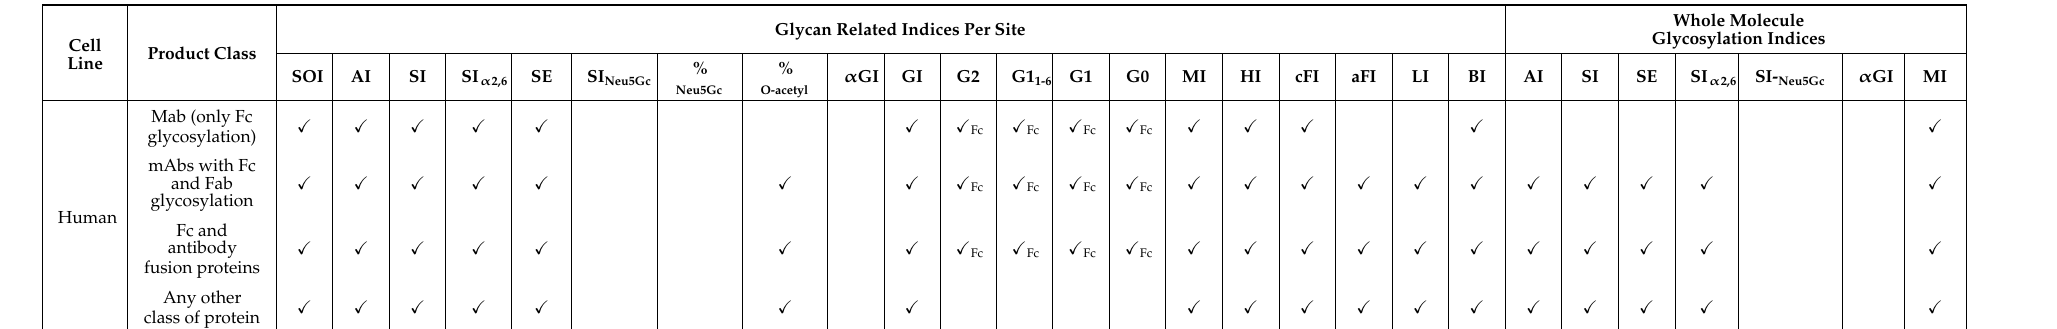
Table 1. Cont. Glycan Related Indices Per Site Whole Molecule Glycosylation Indices